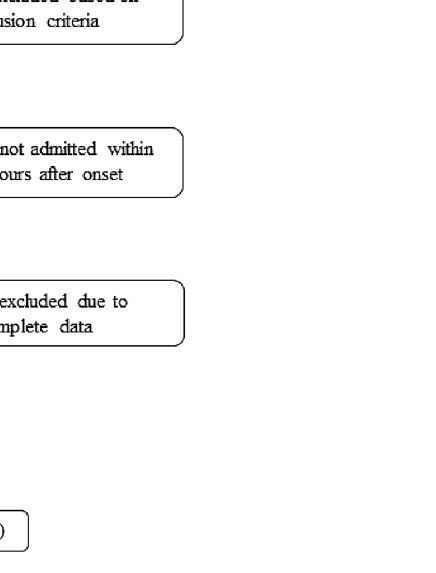
Figure 7. Procedures for patient enrolment and